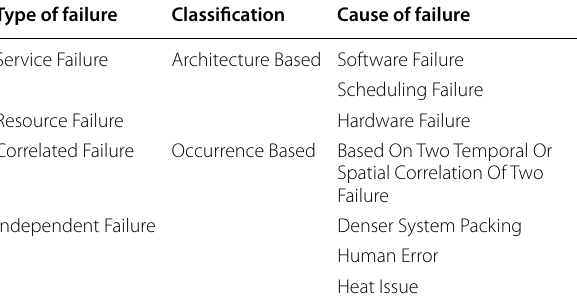
Table 1 Classification of failure and its cause